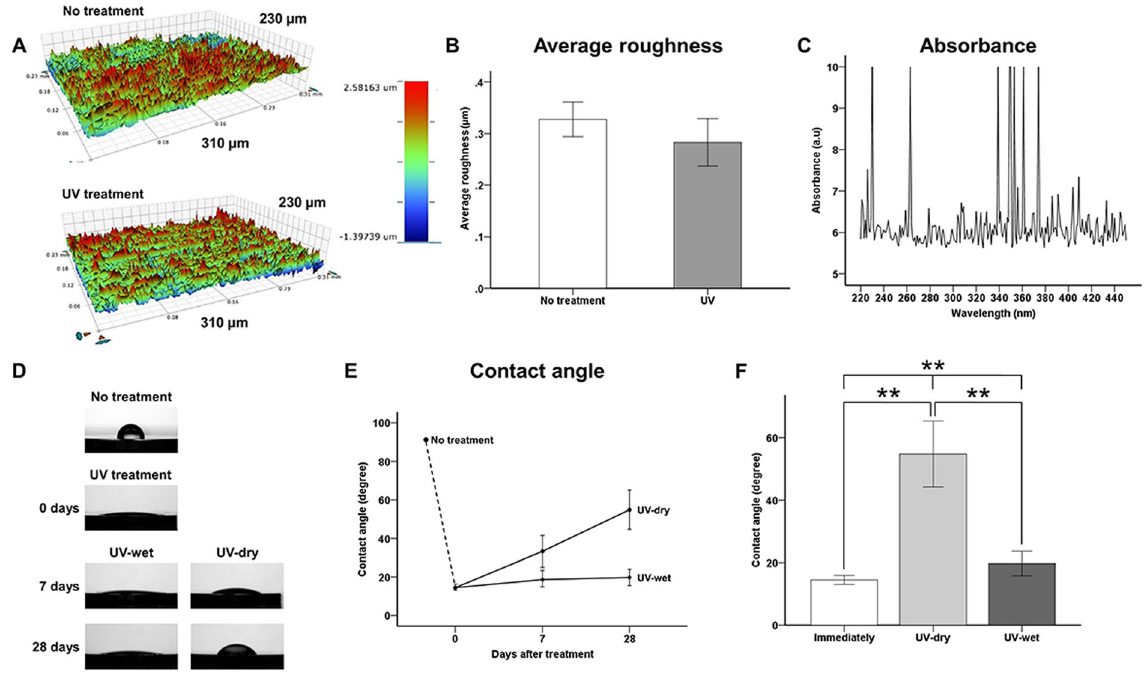
Figure 1. Surface characteristics of titanium discs. ( A ) Three-dimensional surface topographic images of surfaces of untreated titanium discs and immediately after UV treatment. ( B ) Surface average roughness quantitatively measured at a magnification of 10 × with a scanning area of 310 µ m × 230 µ m. ( C ) Optical properties (absorbance units) of titanium surfaces as obtained with UV-Vis-NIR spectrophotometer. ( D ) Comparison of wettability by water, as measured using a 4- µ L d H 2 O droplet at the centre of each sample surface, for each group. ( E , F ) Comparison of contact angle with the titanium disc surface, for each group. UV-dry, immediately after UV treatment, specimen stored in sealed 12-well cell culture plates under sterile humidified conditions at 37 °C in 5% CO 2 for 28 days. UV-wet, immediately after UV treatment, specimen stored in sealed 12-well cell culture plates with dH 2 O under sterile humidified conditions at 37 °C in 5% CO 2 for 28 days. ** P < 0.01 for comparisons between